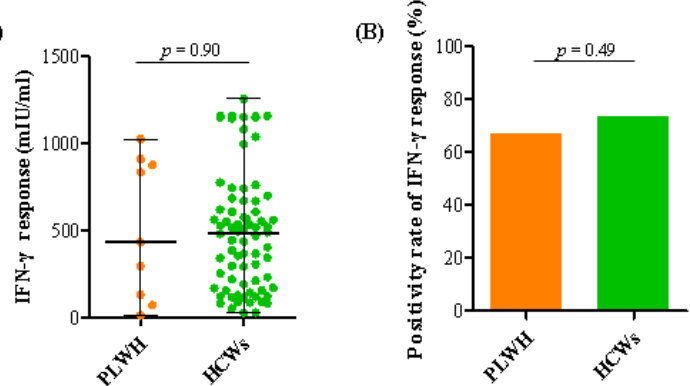
Figure 4. SARS-CoV-2-specific T cell responses at median 65 and 64 days after a third COVID-19 vaccination in people living with HIV (PLWH) and healthcare workers (HCWs). ( A ) Interferon- gamma (IFN- γ ) responses and ( B ) positivity rates of IFN- γ releasing assay (IGRA).